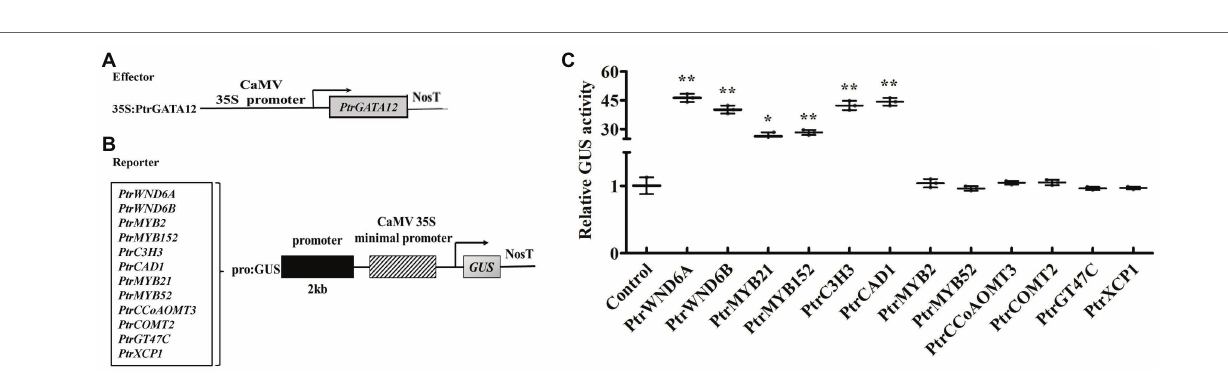
FIGURE 8 | Activation or repression of the promoters of poplar transcription factors and secondary cell wall (SCW) pathway genes by PtrGATA12. (A,B) Diagrams of the effector and reporter constructs. (C) The expression of the β -glucuronidase (GUS) under the control of those promoters by PtrGATA12. GUS activity in tobacco leaves transfected with the reporter construct alone was used as a control and was set to 1. Error bars represent SD of three biological replicates. Asterisks indicate levels of significance of differential expression (Dunnett’s test; *, 0.01 < p < 0.05, **, p <